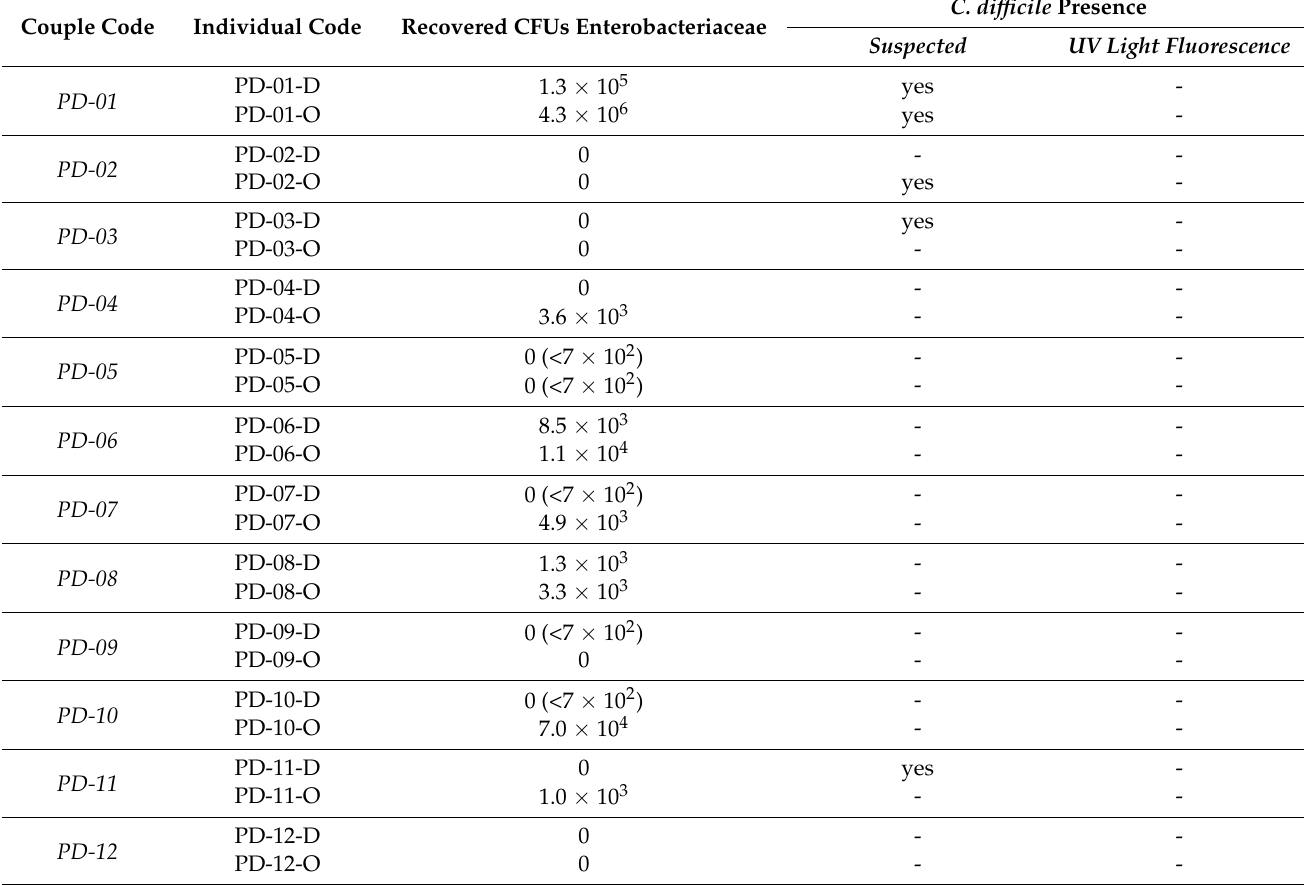
Table A2. Pet dogs: raw microbiological analysis